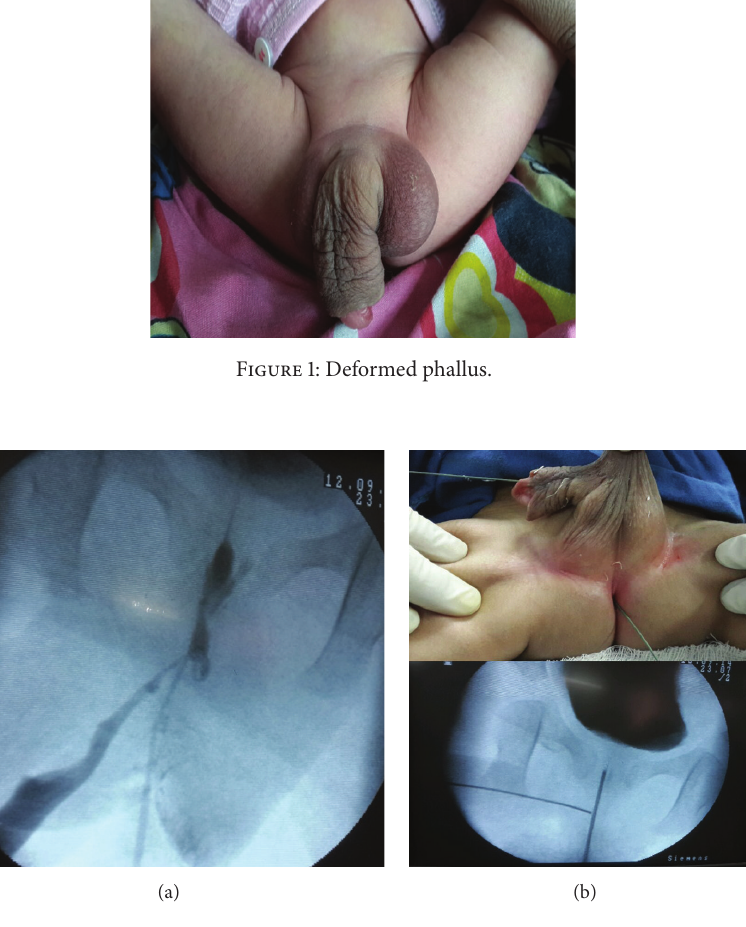
Figure 2: (a) Retrograde urethrography showing Y-type duplication and dilated penile urethra with narrowing in bulbar urethra. (b) Guide wires negotiated through penile meatus and perianal opening.